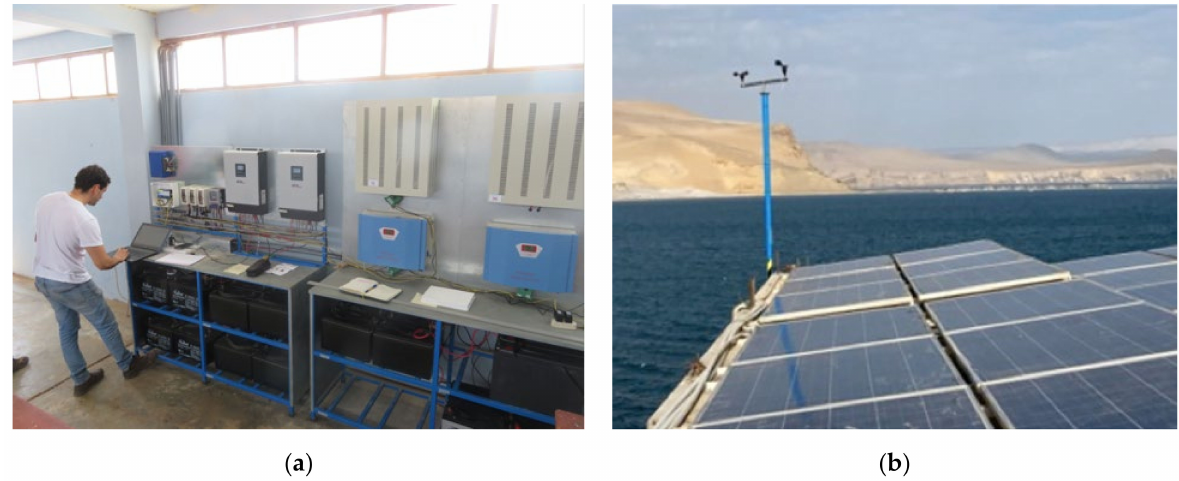
Figure 5. ( a ): Overview of the inverters, controls, and battery consoles of the Laguna Grande microgrid, ( b ): view of the rooftop-mounted PV array with the anemometer and wind vane in the